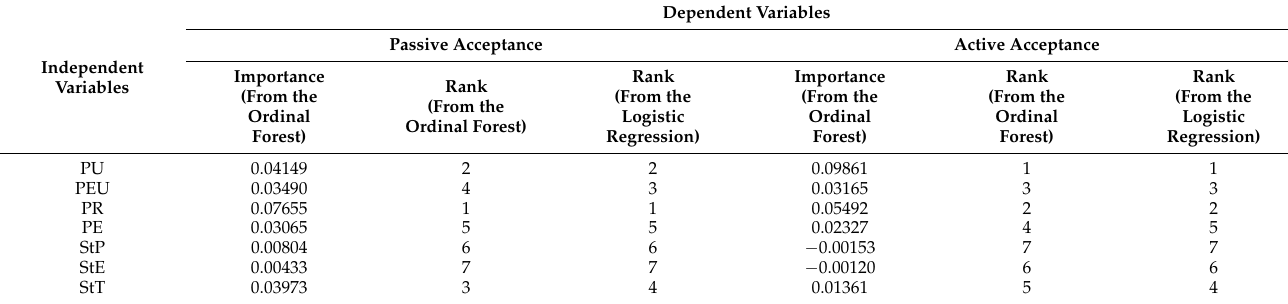
Table 6. Variable importance derived from the ordinal